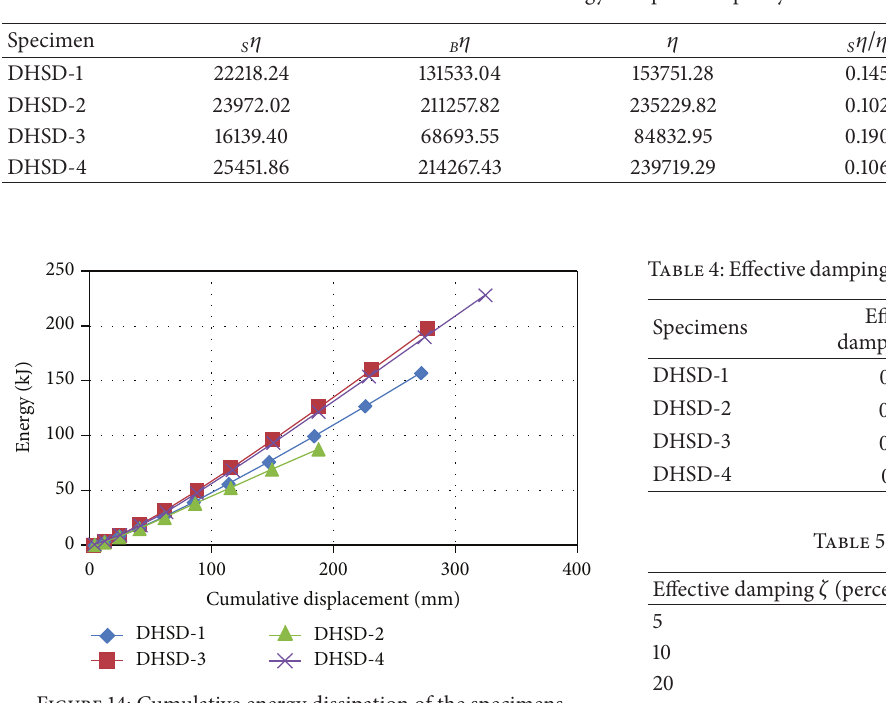
Figure 14: Cumulative energy dissipation of the specimens.